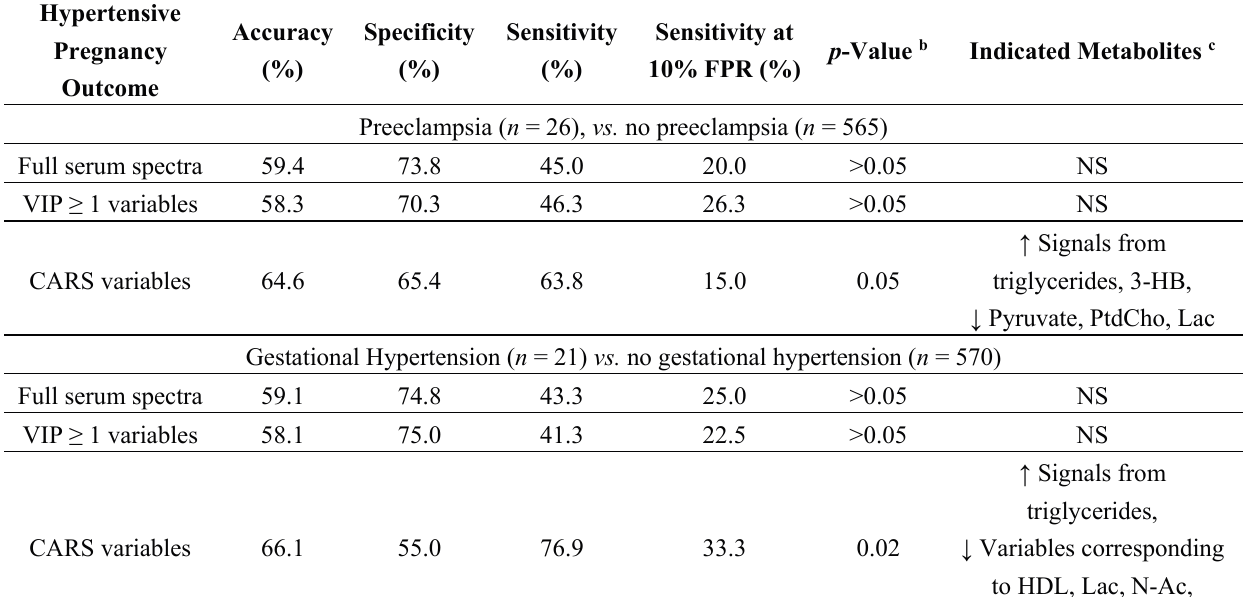
Table 3. Serum metabolite multivariate models predicting preeclampsia and/or gestational hypertension a